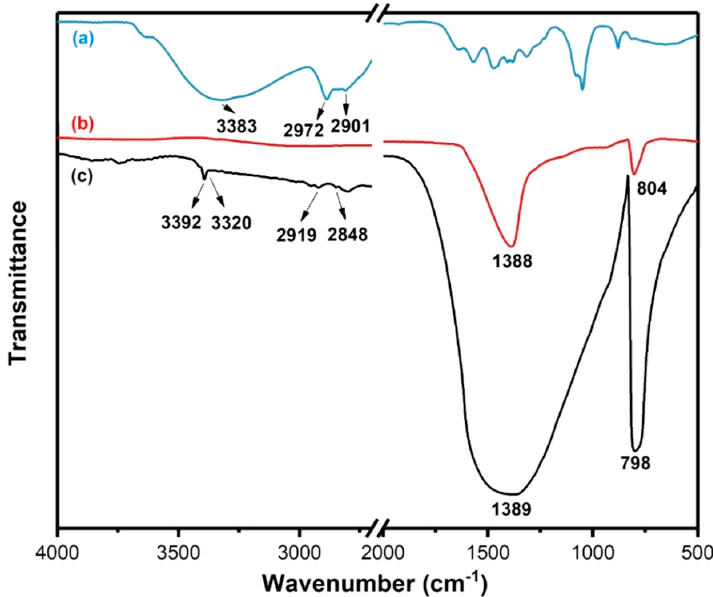
Figure 5. FTIR spectra patterns of ( a ) PEI, ( b ) pure h-BN particles and ( c ) h-BN-PEI.